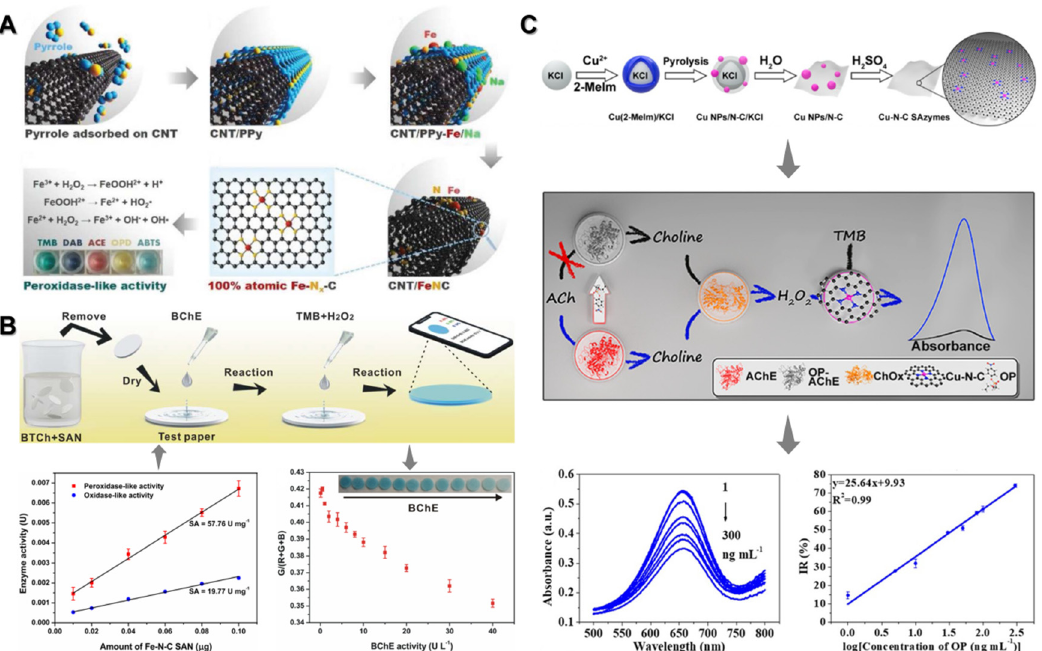
Figure 2. ( A ) Preparation of CNT/FeNC SAN with a high peroxidase-mimetic activity (reprinted with permission from Ref. [41]). ( B ) Fe-N-C SAN with prominent peroxidase-mimicking activity for paper-based bioassay of BChE activity (reprinted with permission from Ref. [44]). ( C ) Design of Cu-N-C SAN with rich Cu sites for organophosphorus sensing (reprinted with permission from Ref. [46]).